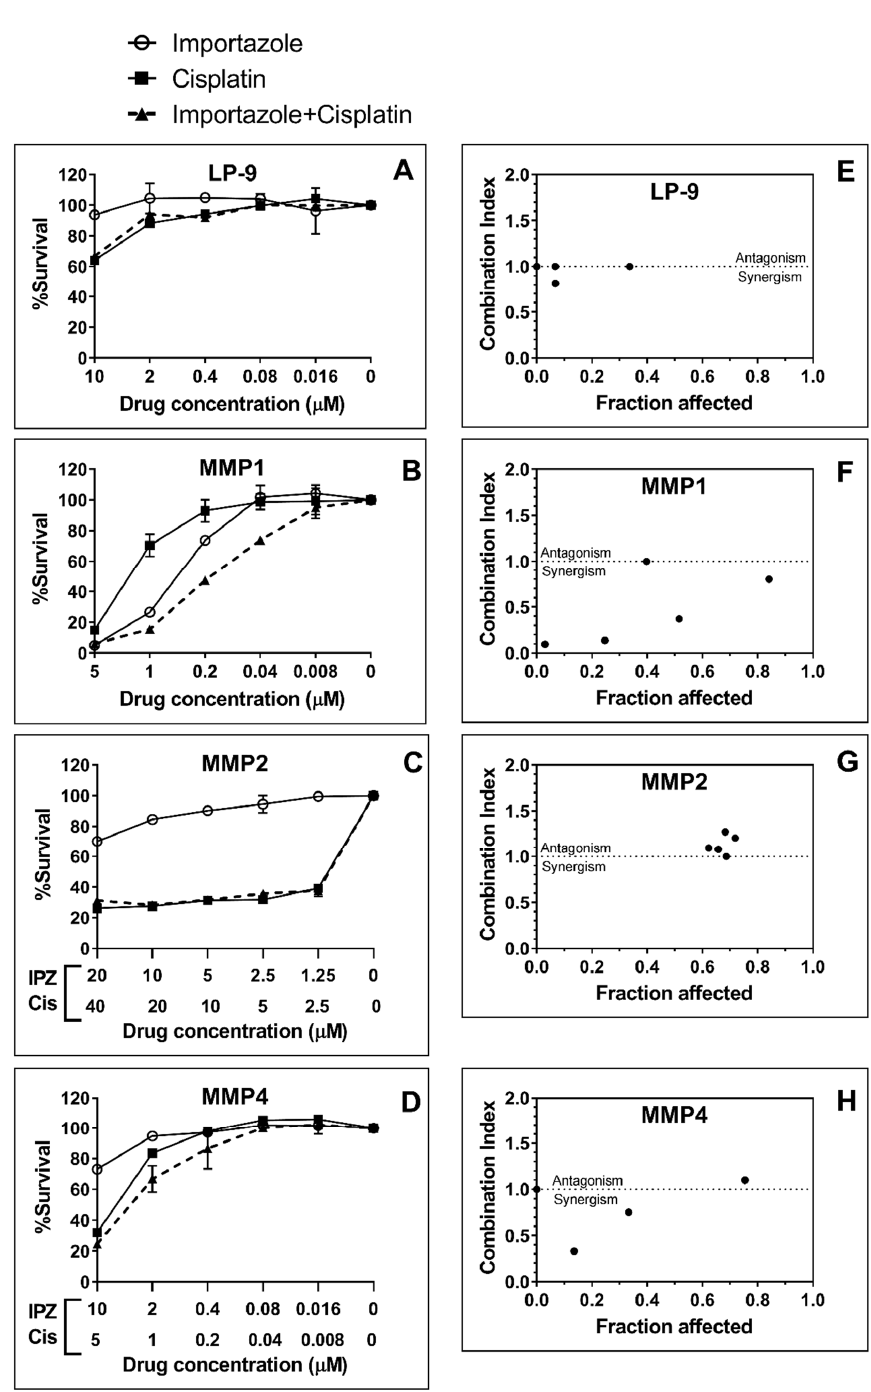
Figure 10. Cytotoxicity produced by IPZ and cisplatin (Cis) in LP-9 and primary cells MMP1, MMP2, and MMP4. ( A–D ) The dose-response cell survival was assessed after the cells were exposed to various concentrations of IPZ, Cis, or a combination of both (dashed lines) for 72 h of treatment. ( E–H ) The fraction a ff ected-CI plots were constructed by CalcuSyn software, showing synergism (CI < 1), additive e ff ect (CI = 1), and antagonism (CI > 1). For MMP1 cells (F), CI values of < 1 occurred at a wide range of inhibition levels, indicating synergy produced by the combination of IPZ and